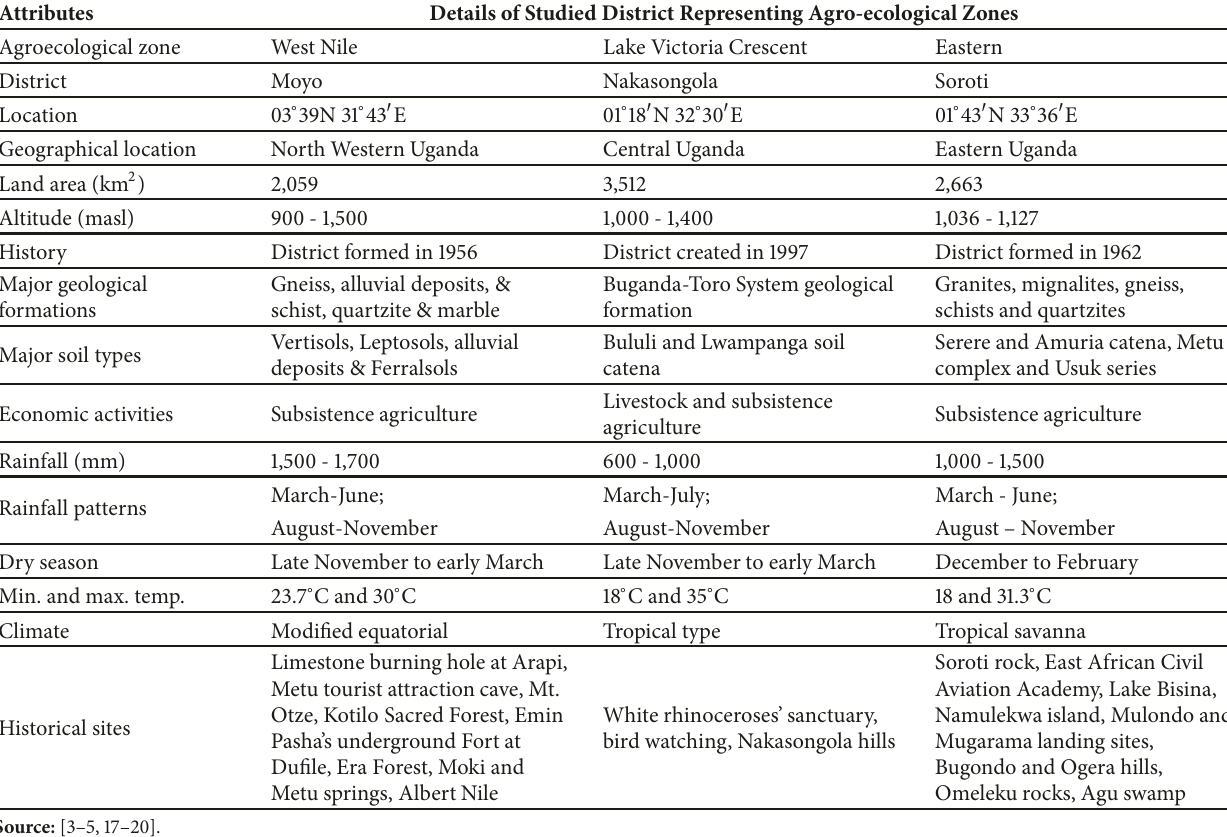
Table 1: Summary of study areas.